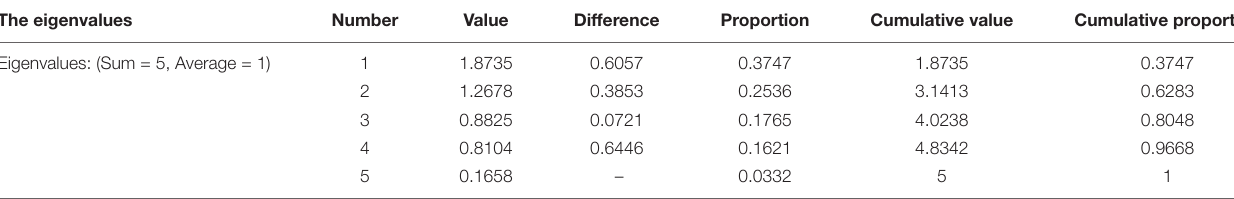
TABLE 4 | Principle component analysis (PCA) of the variables (China). The eigenvalues Number Value Difference Proportion Cumulative value Cumulative proportion